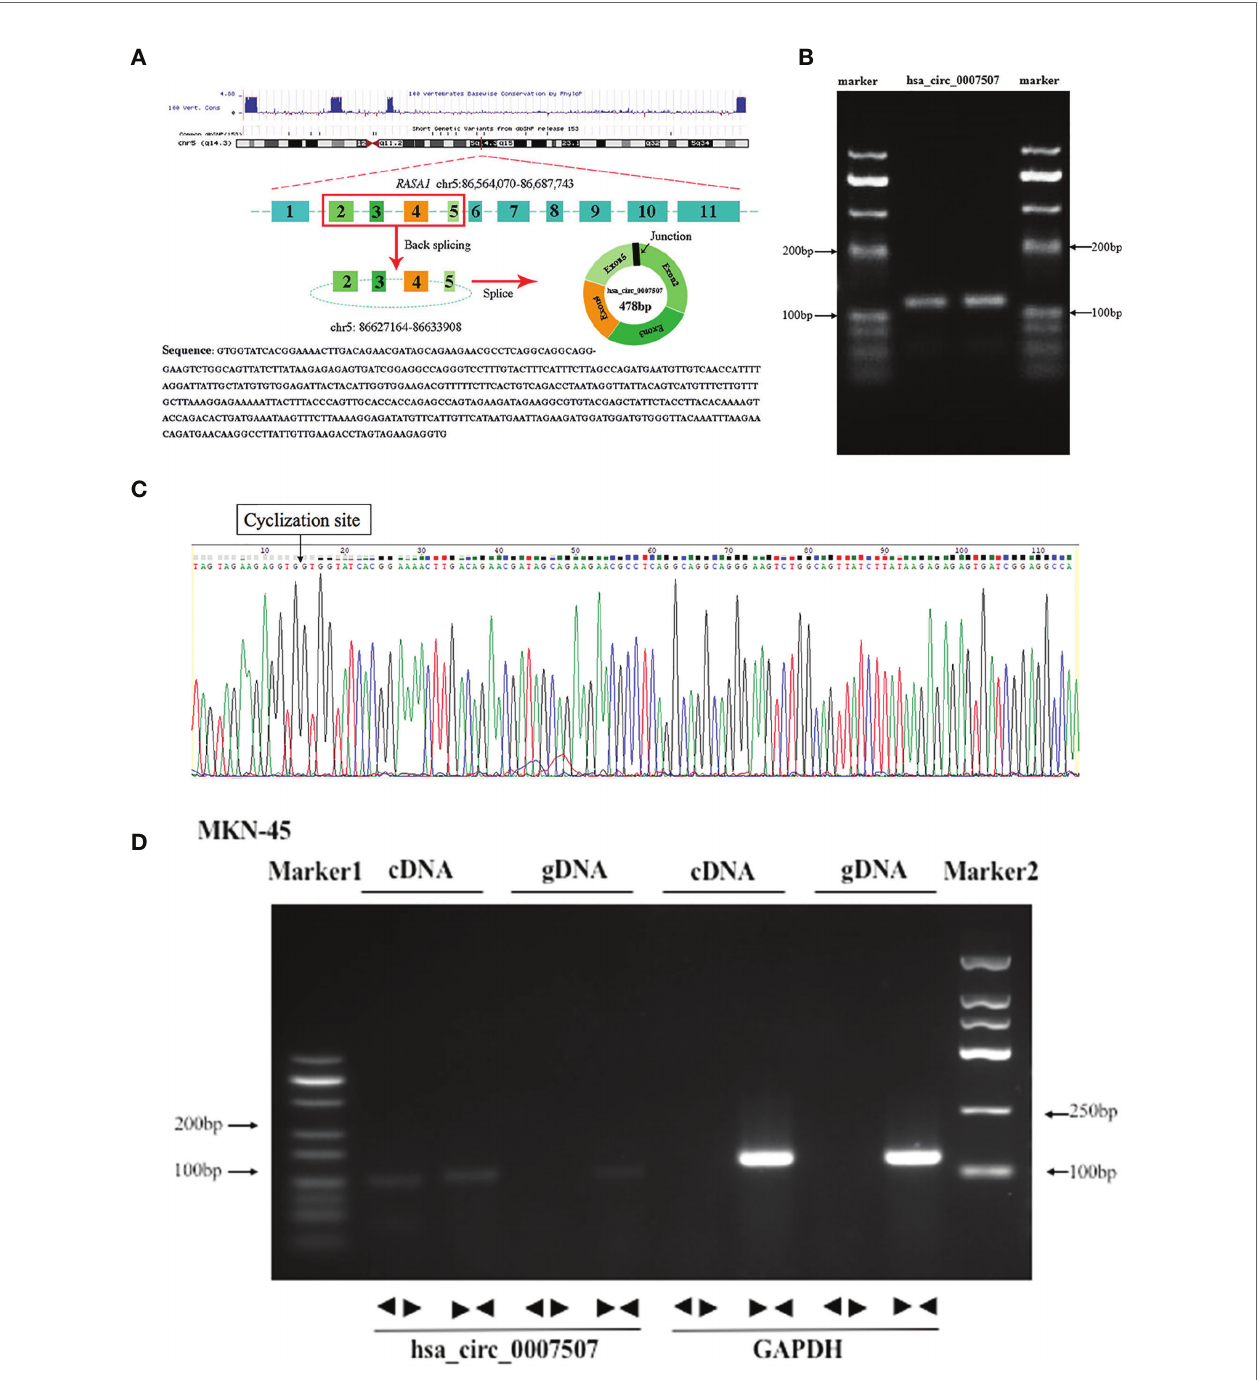
FIGURE 1 | Methodological evaluation of hsa_circ_0007507 in gastric cancer (GC) cells. (A) The origin of hsa_circ_0007507 searched through the University of California Santa Cruz (UCSC) genome browser. (B) Veri fi cation of the size of the primer ampli fi cation product (112 bp) by agarose gel electrophoresis. (C) Detection of the cyclization site by Sanger sequencing. (D) Veri fi cation of the ring structure of